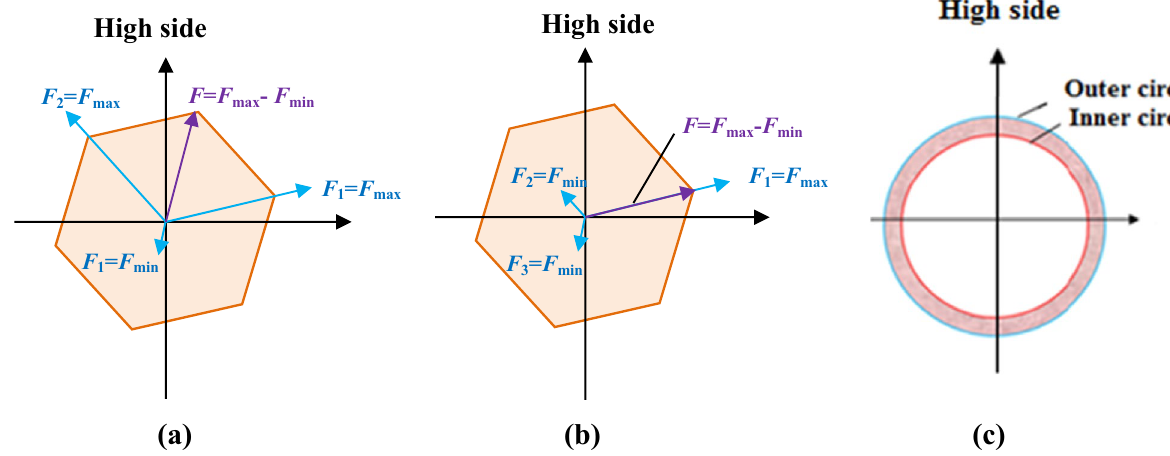
Fig. 2 Inner circle and outer circle hosting the hexagon of maximum pad force